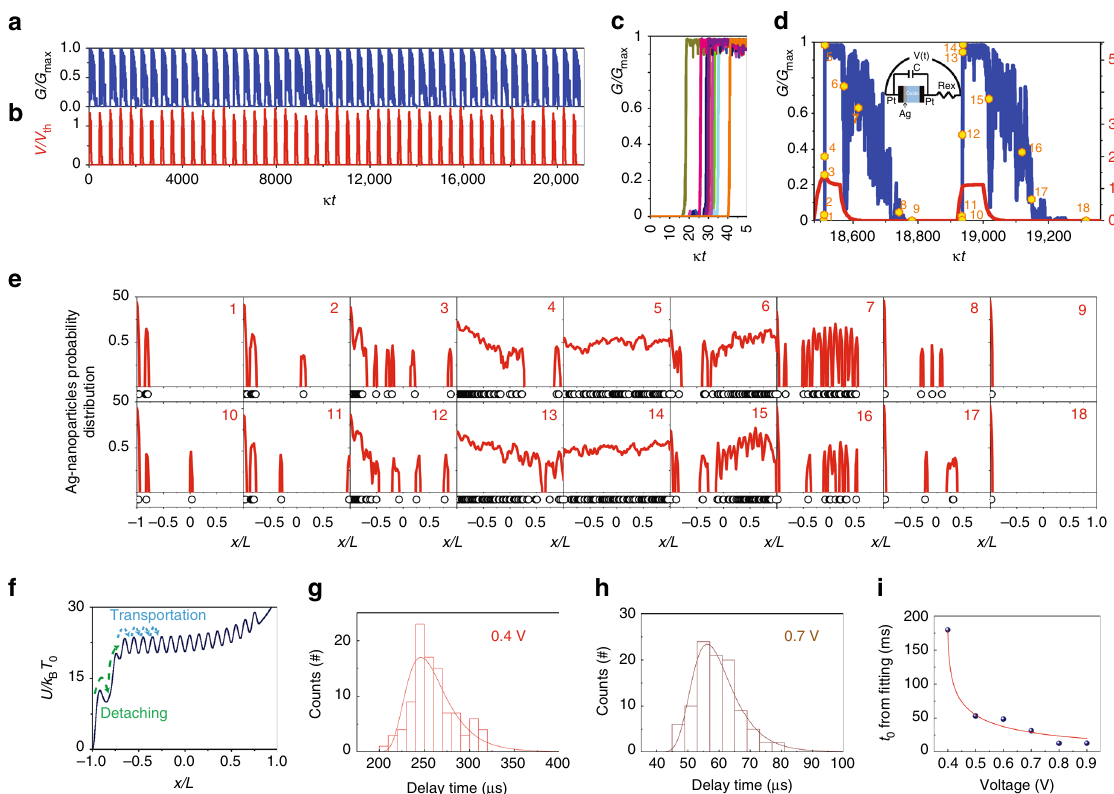
Fig. 4 Physical origin of stochastic delay time clari fi ed by nanoparticle dynamics simulations. a The switching of the simulated memristor conductance when 48 rectangular voltage pulses are applied, with conductance normalized by the maximum memristor conductance, and b the variation of voltage across the memristor, normalized by the threshold voltage V th . c The switching to the low resistive state at time measured from the beginning of the corresponding pulses. The randomness of the resistive switching is clearly seen. d The two chosen resistive switches with different delay time and e corresponding particle probability distributions (1 – 18) marked on d by yellow points . Inset in d shows the circuit model used during the simulation. The memristor is connected with a parallel capacitor and a series resistor. f Potential normalized by thermal fl uctuations across the sample used here. The delay time is composed of charging time of capacitor, time of Ag particles detach from Ag reservoir and the Ag transportation time until the formation of conduction channel(s), while the stochasticity is mainly attributed to the stochastic detaching process. For simulations in a – e , we used the following voltage pulse parameters: voltage pulse duration κ t p = 80 (allowing enough time to switch to low resistive state for every pulse), inter-pulse interval κ Δ t = 360 (allowing enough times to relax) and voltage amplitude V V = 1.6, potential versus temperature as in f (all times measured in unit of thermal am / th relaxation time 1/ κ ). The experimental delay time distributions under ( g ) 0.4 V and ( h ) 0.7 V fi tted by eq. 2. i The fi tting curve of t 0 vs. pulse amplitudes according to eq. (3). The fi tted probability distributions appear to be consistent with experimental results, con fi rming the feasibility of our